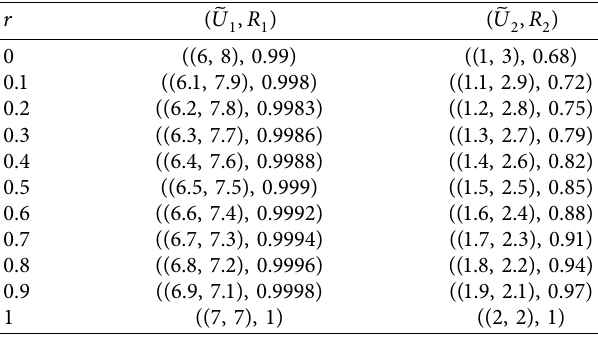
Table 3: Te diferent values of [ U ] Z for λ � 1 and r � 0 , 0 . 1 , ... , 1.